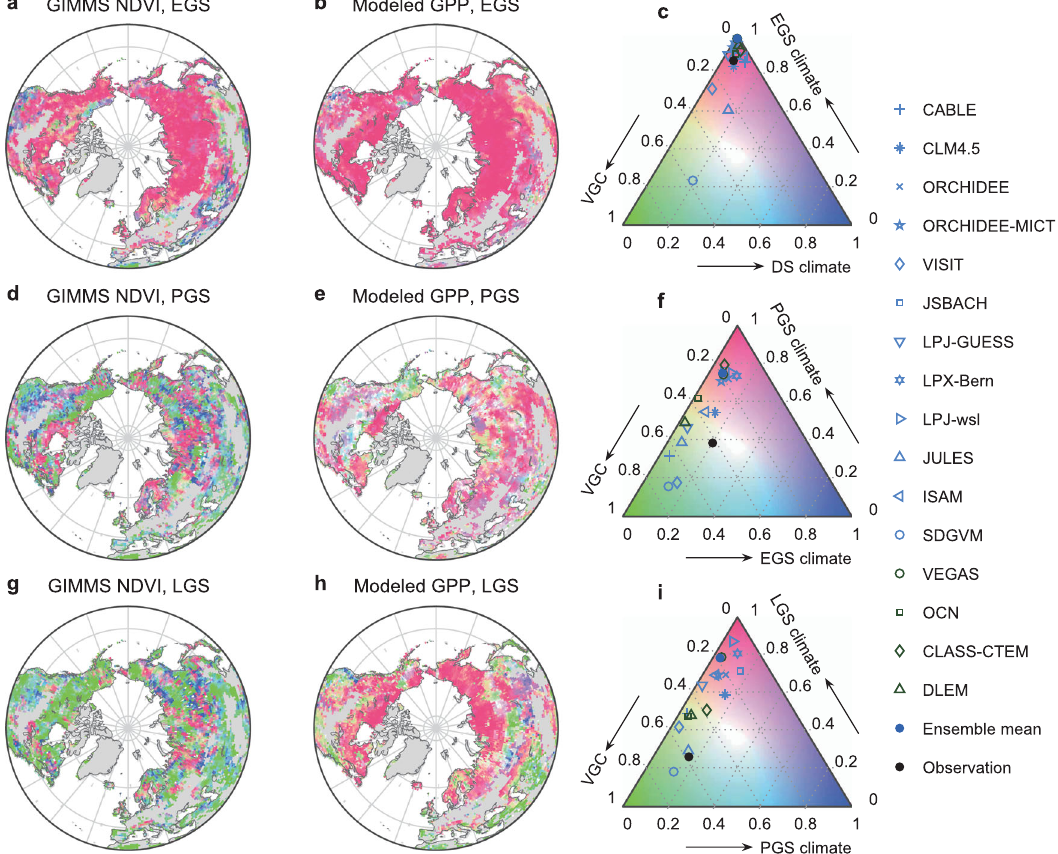
Fig. 5 Observed versus modeled vegetation growth carryover effects. Spatial patterns show the relative contributions of vegetation growth carryover (VGC) and climatic factors of the present and preceding seasons to the interannual variations of Normalized Difference Vegetation Index (NDVI) or gross primary productivity (GPP). Maps in the left column represent satellite-observed NDVI, and those in the right are the model ensemble-mean GPP for early growing-season (EGS) ( a , b ), peak growing-season (PGS) ( d , e ), and late growing-season (LGS) ( g , h ). Ternary diagrams in c , f , i show the relative fraction of global vegetated areas where the interannual trend of GPP (or NDVI) is dominated by each different driver (corresponding to the maps in each row). Both percentages of the model ensemble-mean (closed blue circles) and the individual models (open symbols) and of satellite observation-based estimates (closed black circles) are shown.